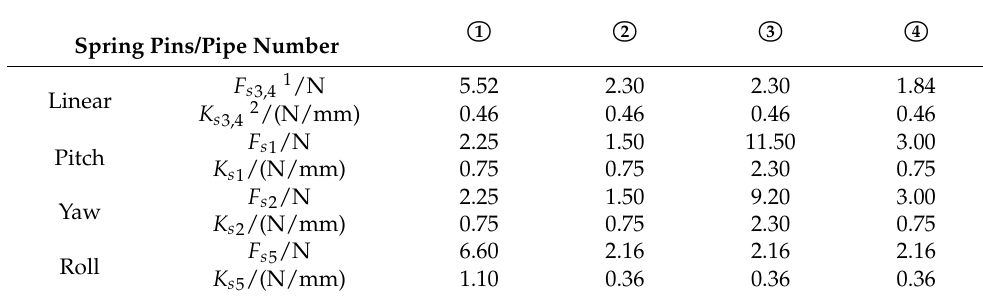
Table 6. Parameters of the matched spring